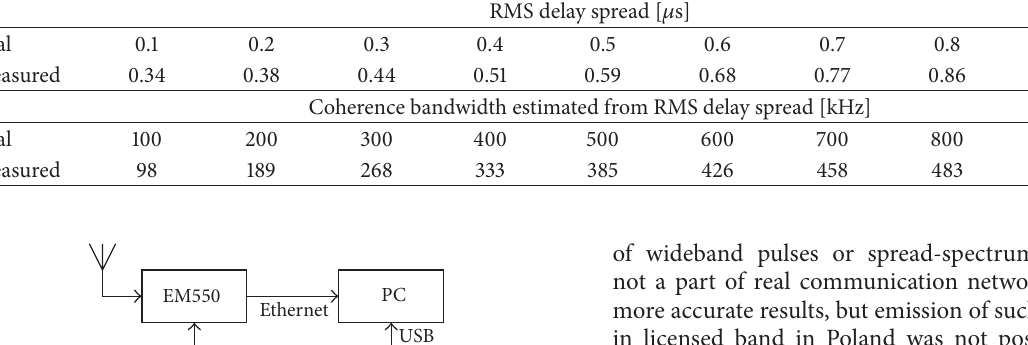
Table 1: Relation between measured and real parameters of radio channel for 𝜎 𝜏,